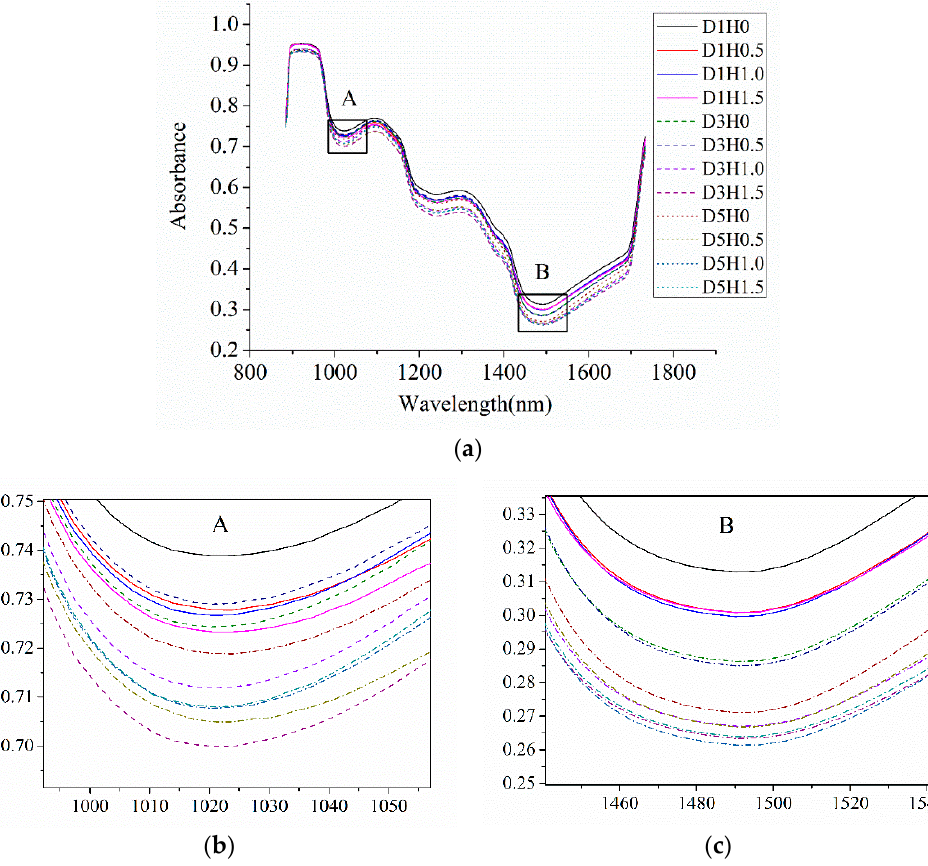
Figure 4. Mean spectra of mango samples (damaged and undamaged) for three days at three different dropping heights. ( a ) overall mean spectra; ( b ) enlarged picture near the wavelength 980 nm; ( c ) enlarged picture near the wavelength 1500 nm.